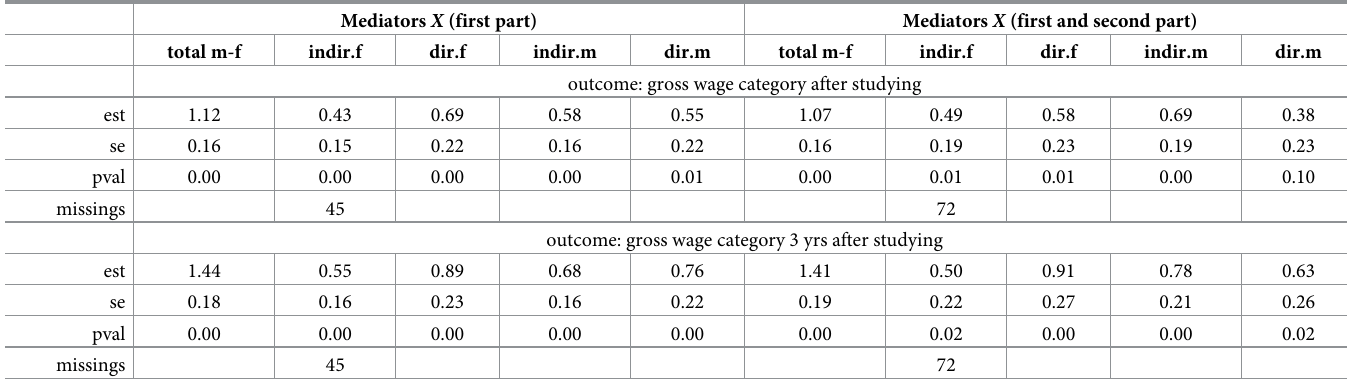
Table 6. Oaxaca-Blinder